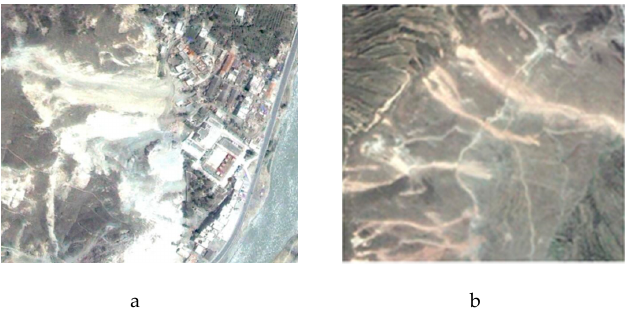
Figure 1. A comparation of landslides happened in different places. The risk of a landslide happens in a densely populated area ( a ) is greater than that happened in an uninhabited area ( b ).